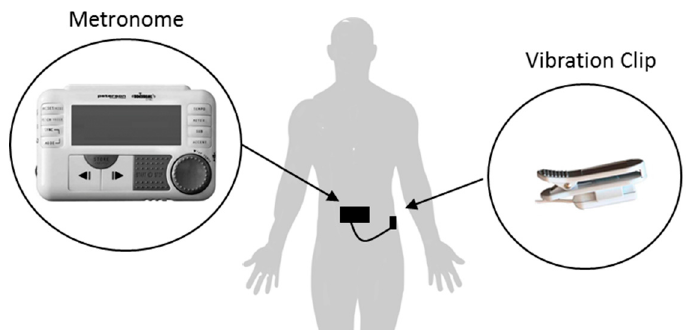
Figure 14. Illustration of a participant wearing the BodyBeat Pulsing Metronome. The metronome was clipped to a belt at the back of the participant and the vibration clip was placed anteriorly over the right side of the pelvis.